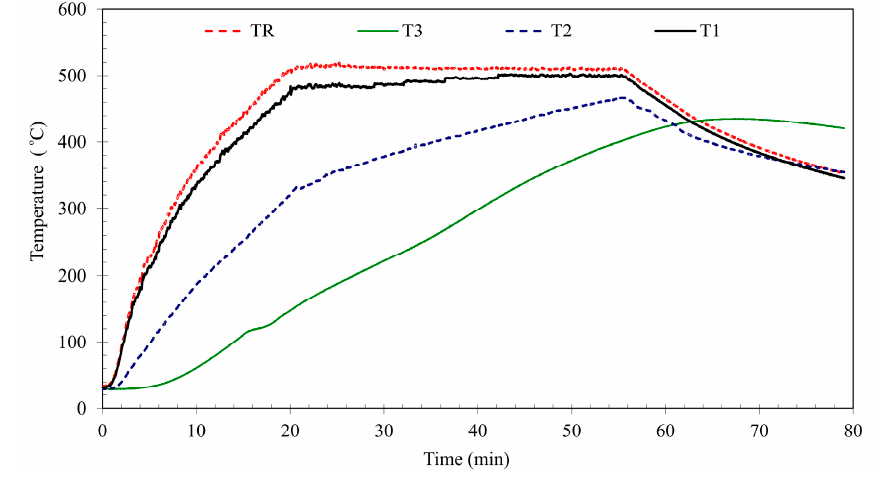
Figure 8. Temperature distribution in the OC pilot sample. Heating curve 500 °C.